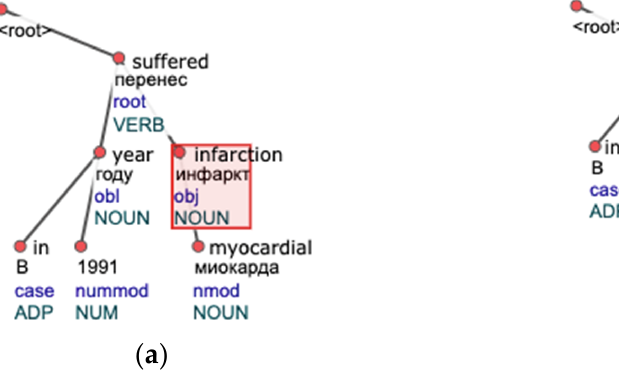
Figure 3. Tree examples of sentences where the algorithm for full repeat search will not find any repeating subtrees: ( a ) A tree contains a mention of disease: “infarction myocardial”; ( b ) Another tree containing “infarction myocardial” but with an extra child node with the word “second”, making it a partial